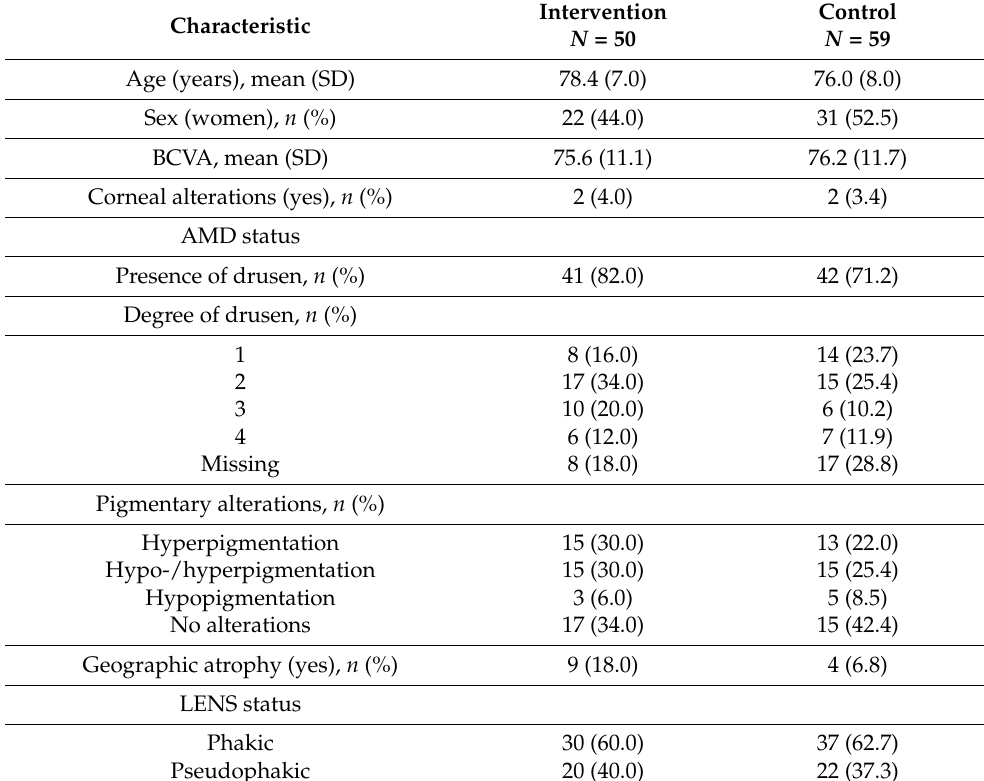
Table 1. Baseline